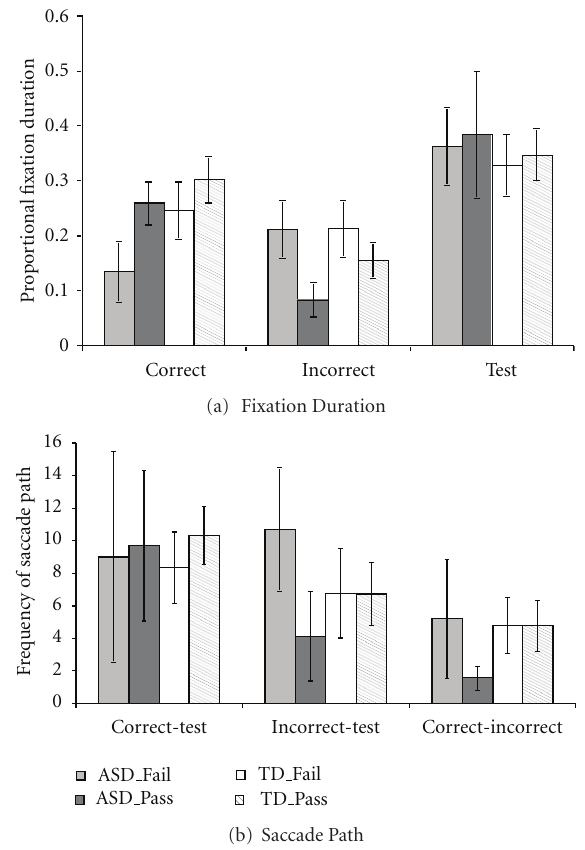
Figure 4: Proportional fixation durations within the correct, incorrect, and the test cards (a) and frequencies of the correct- test path, the incorrect-test path, and the correct-incorrect path (b) for ASD and TD children who passed and failed in the postswitch phase. (Error bars represent 95% confidence